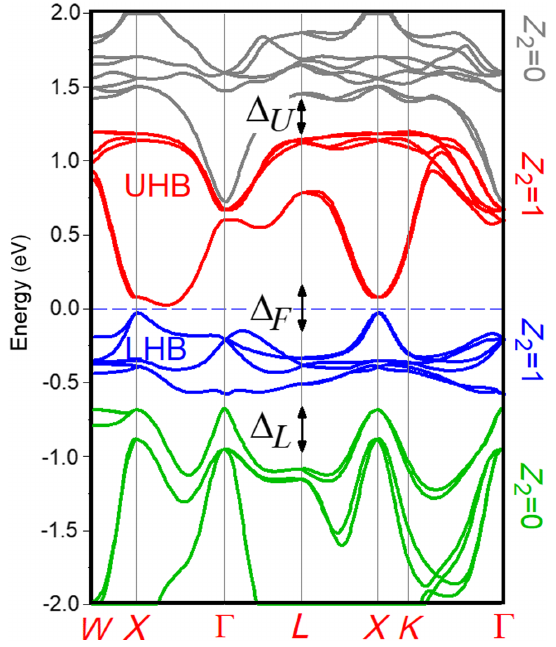
FIG. 2. Calculated electronic structure of UNiSn using the density functional theory combined with dynamical self-energies for the uranium f electrons assuming the experimentally deter- mined 5 f 2 Γ 3 doublet as a ground state [34]. The locations of energy panels with nonzero Z 2 invariants and corresponding gaps ( Δ , Δ , and Δ ) are L F U